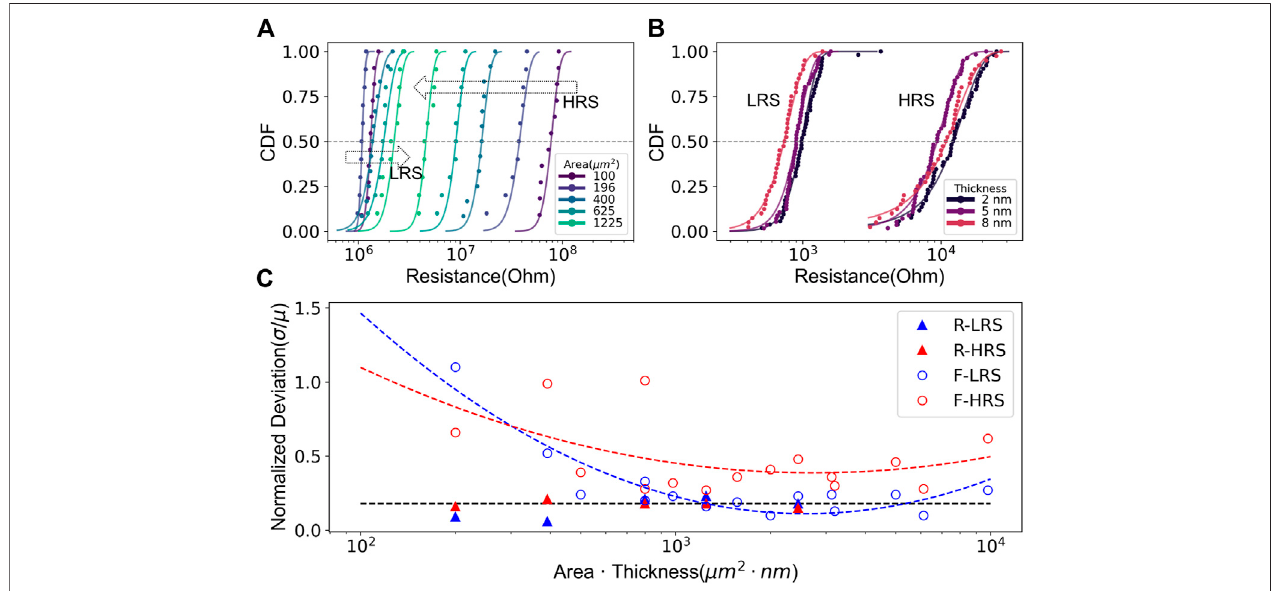
FIGURE 4 | Resistance distribution for different physical device parameters in type R devices (A) , and type F devices (B) . (A) CDF for different active device area sizesofdevicetypeR.Thearrowspointtothedirectionoftheincreasingarea. (B) CDFfordifferentHfO x thicknessesintypeFdevices. (C) Devicevariability ( σ / μ ) interms of physical device parameters. The variability of type R devices is marked with triangles, and type F devices with circles. Red color for high resistance states, and blue colorforthelowresistancewereused.The fi ttedcurvesareshownwithdashedlines.FortypeFdevicesaparabolictrendwasobserved,whichshowsacorrelation between the area and the thickness of the HfO x in the variability of